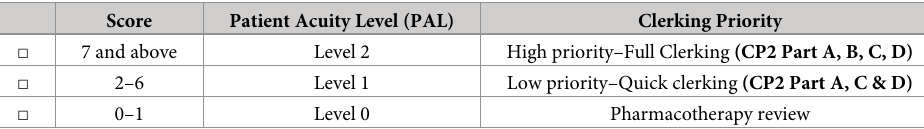
Table 4. Rating results of PAST scoring